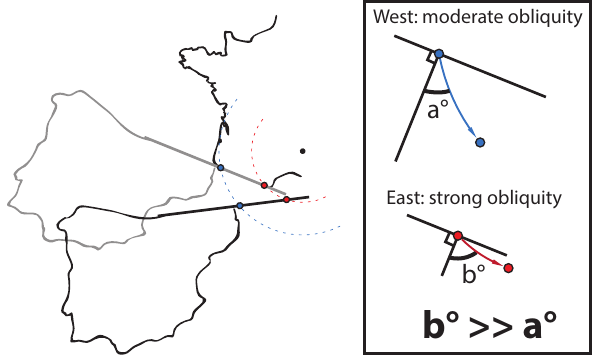
Figure 6. Example of variable mode of extension along a single linear plate boundary. In this example, the eastern domain of the fu- ture NPZ undergoes transtension with a strong left-lateral obliquity, while the western domain opens with a moderate